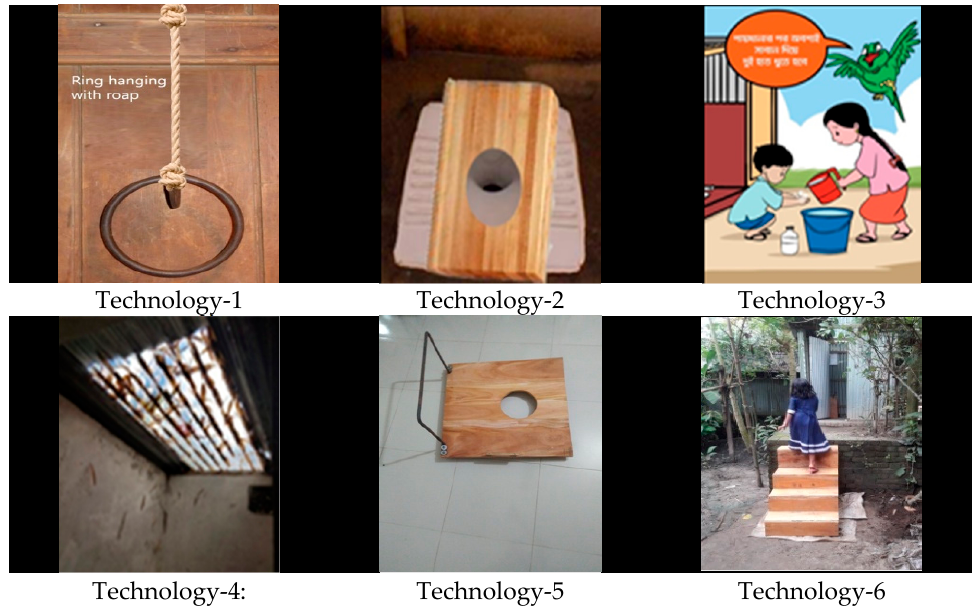
Figure 1. Enabling technologies from the two trials of improved practices. Technology-1: Iron ring hanging with rope inside the latrine to hold while squatting; Technology-2: Wooden seat placed on the pan to reduce the distance between children’s feet while squatting; Technology-3: Cartoon image with hygiene message to attract children inside the latrine; Technology-4: Transparent fiberglass roof tile to address children’s fear of the darkness; Technology-5: Wooden seat with the handle placed on the pan to make children sit comfortably; Technology-6: Stair to facilitate latrine access.